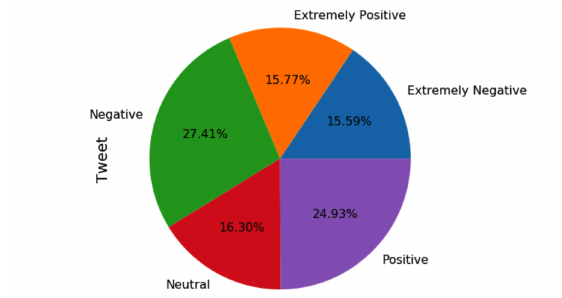
Figure 2. Class distribution of the test dataset.